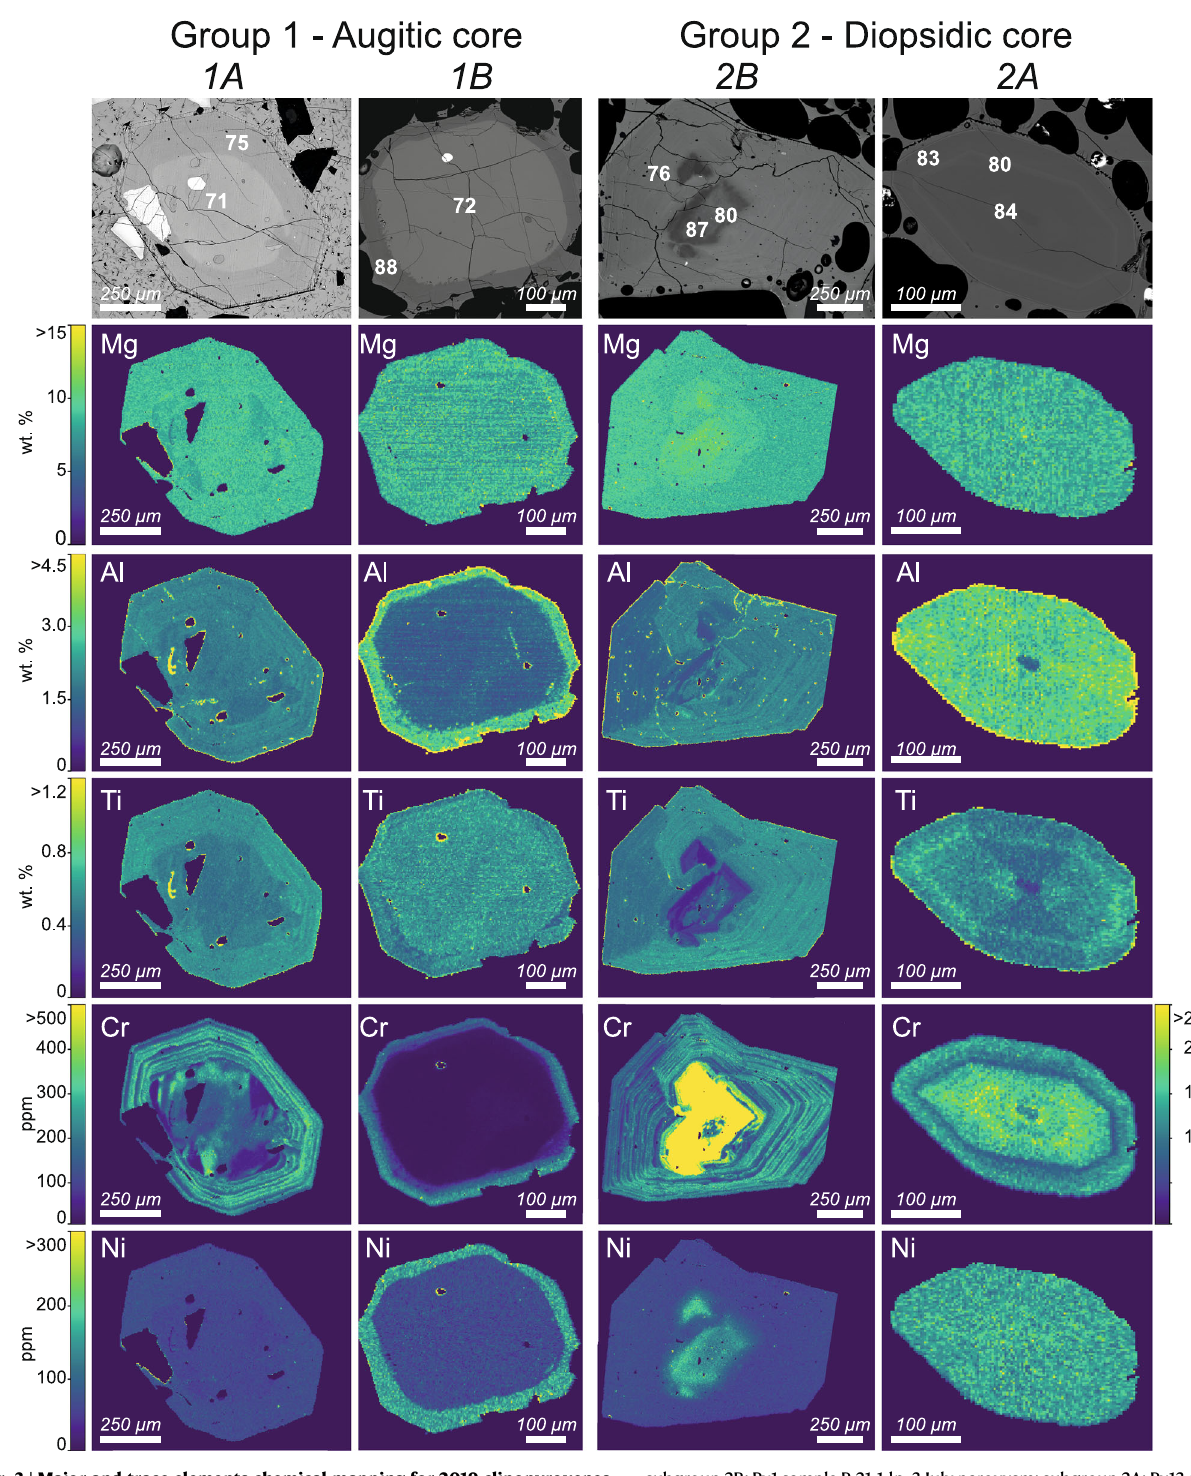
subgroup2B:Px1sampleP-21-1-lp,3Julyparoxysm;subgroup2A:Px13sampleP30- 07-lp,3Julyparoxysm.ThescalebarforCrisontheleftforsubgroup1A,1Band2B and on the right for subgroup